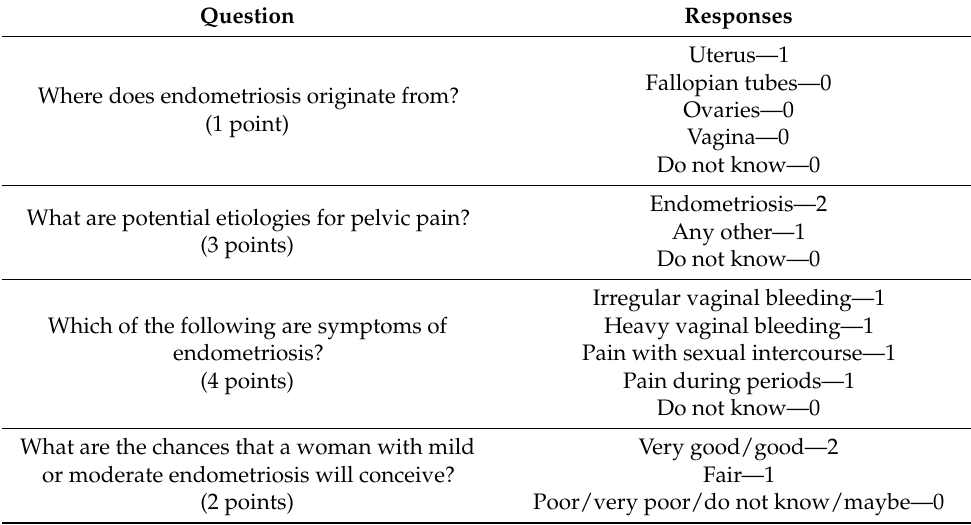
Table 1. The ten-point endometriosis knowledge score (EKS). Question